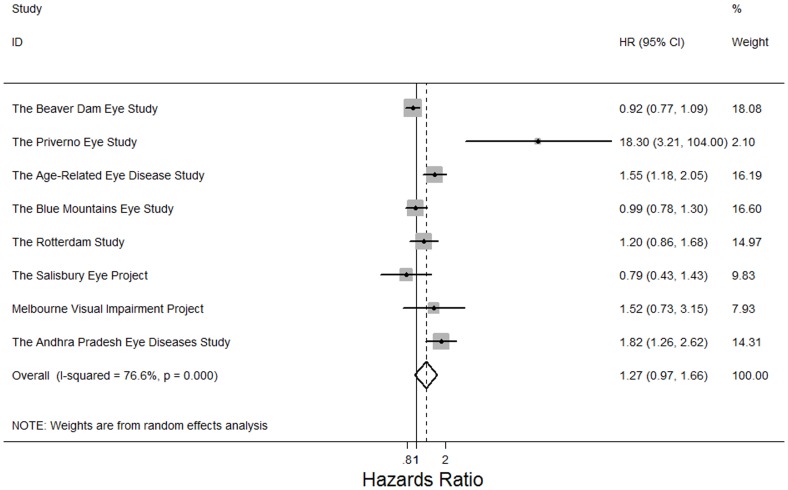
Random effects meta-analysis investigating the association between cataract surgery and all-cause mortality.HR = hazards ratio; CI = confidence interval.